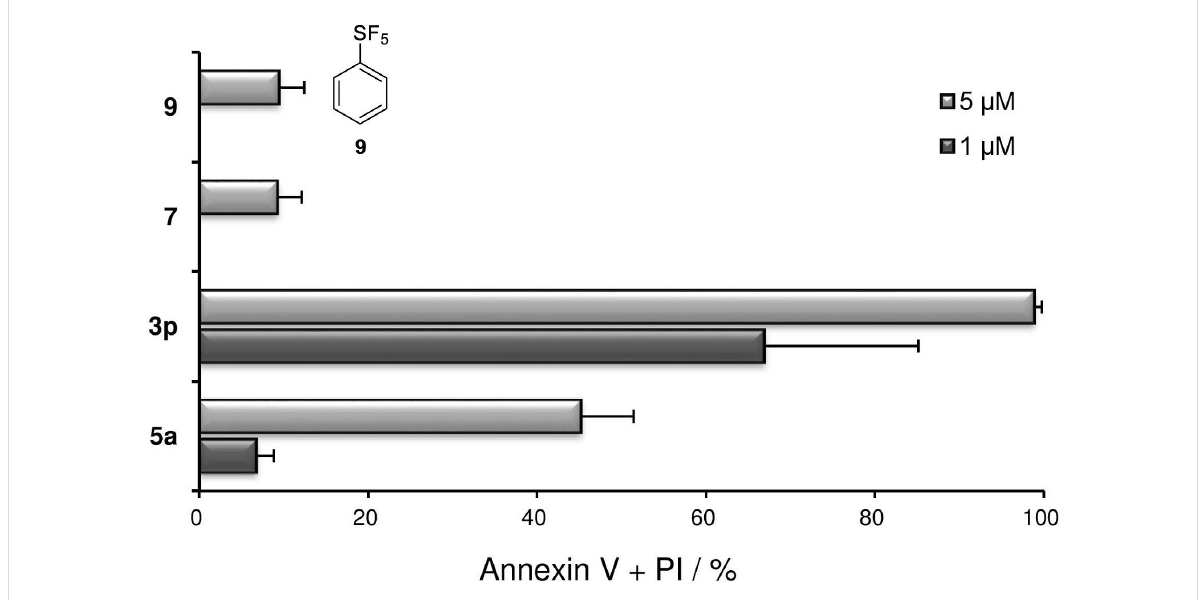
Figure 4: Ortho -SF 5 phenyl iodonium salts 3p and 5a and their structural components 7 and 9 induced cell death in U937 cells. Briefly, U937 cells (1 × 10 4 cells/mL) were incubated with each test compound at 1 μ M and 5 μ M for 24 h. Cells were stained with annexin V and propidium iodide (PI). The data shown is the mean ± SD (n = 3).